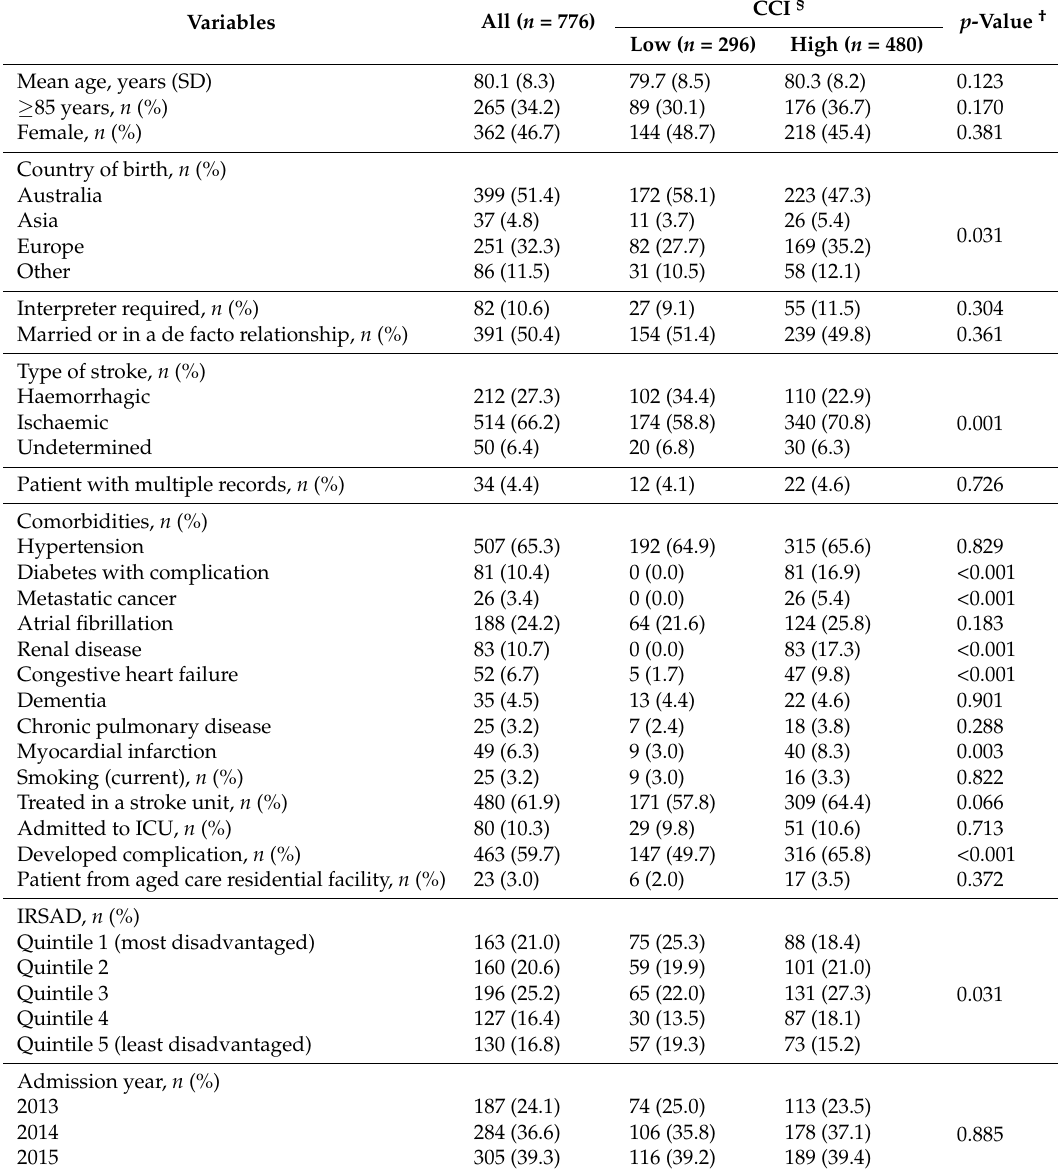
Table 1. Sociodemographic and clinical characteristics of older adults hospitalised for acute